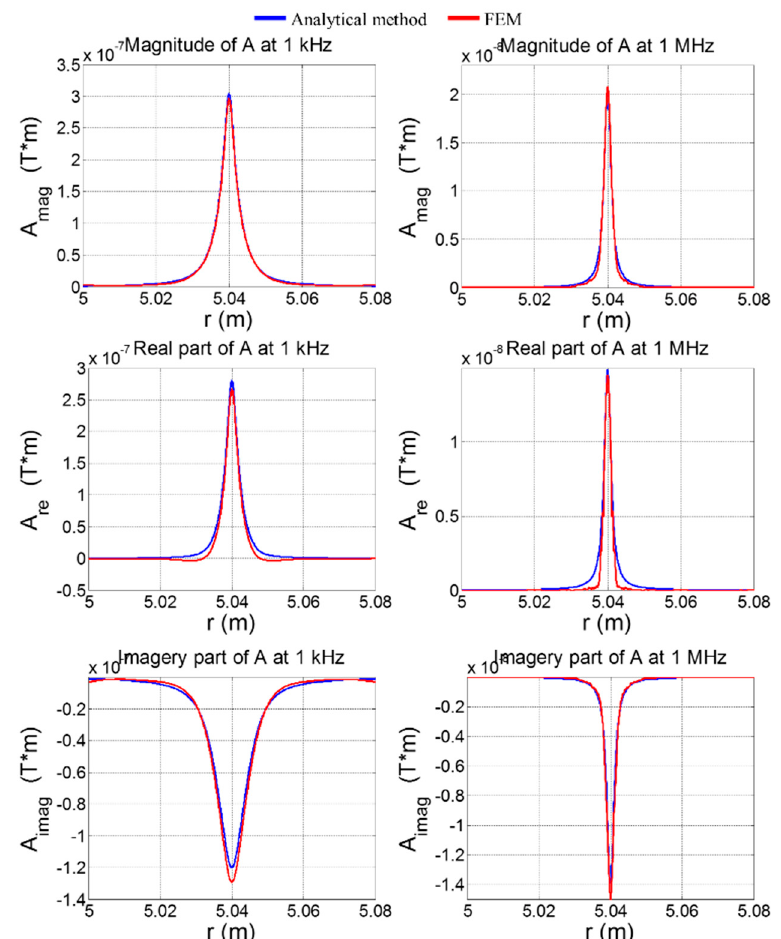
Figure 3. The distribution of A from the adapted analytical solution and the finite element method (FEM). The left curves are the results at 1 kHz, while the right curves are the results at 1 MHz. The red curve is the result from the FEM, and the blue curve is the result from the analytical solutions. Reproduced with permission from [15], IEEE, 2016.